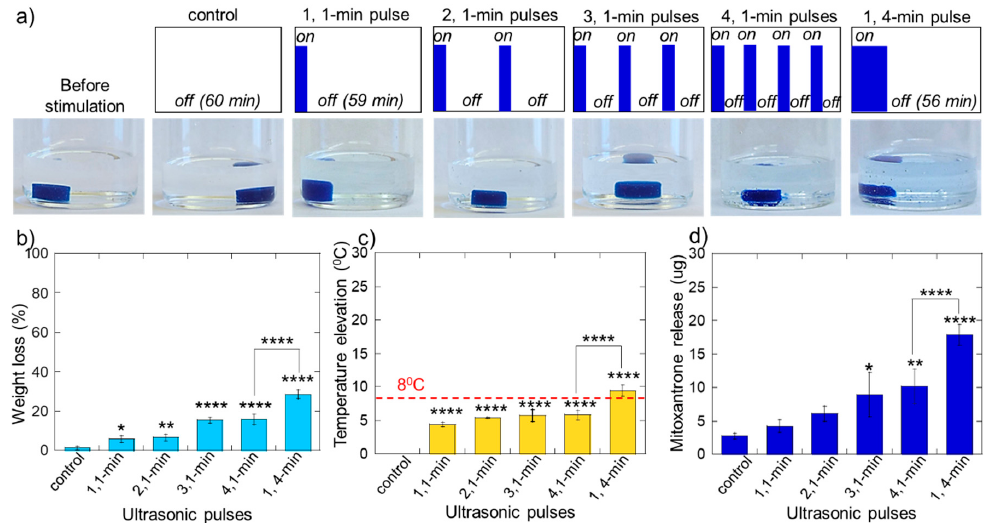
Figure 5. Pulsed ultrasound can enhance drug delivery while helping to control gel erosion and heating. ( a ) Photos of hydrogels (bottom row) after exposure to the illustrated ultrasonic pulse trains (top row). ( b ) Percent weight loss of hydrogels vs. pulse number. ( c ) Temperature rise vs. pulse number. ( d ) Mitoxantrone release vs. pulse number. *, **, ***, and **** indicate statistically significant differences with p < 0.05, 0.01, 0.001, and 0.0001, respectively, compared controls unless otherwise specified with lines. N = 4.